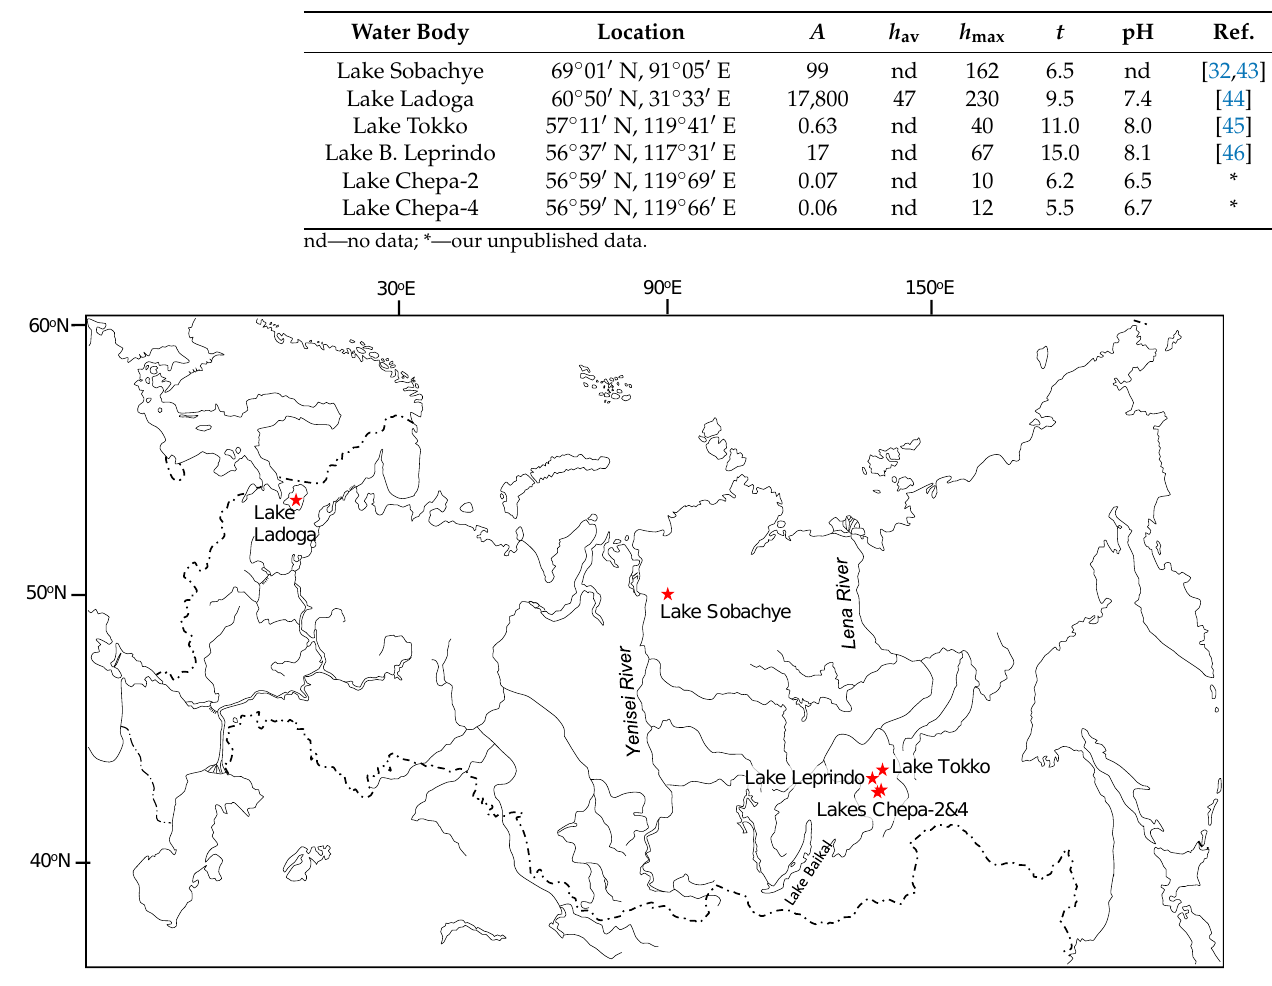
Figure 1. Map of sample sites (stars).